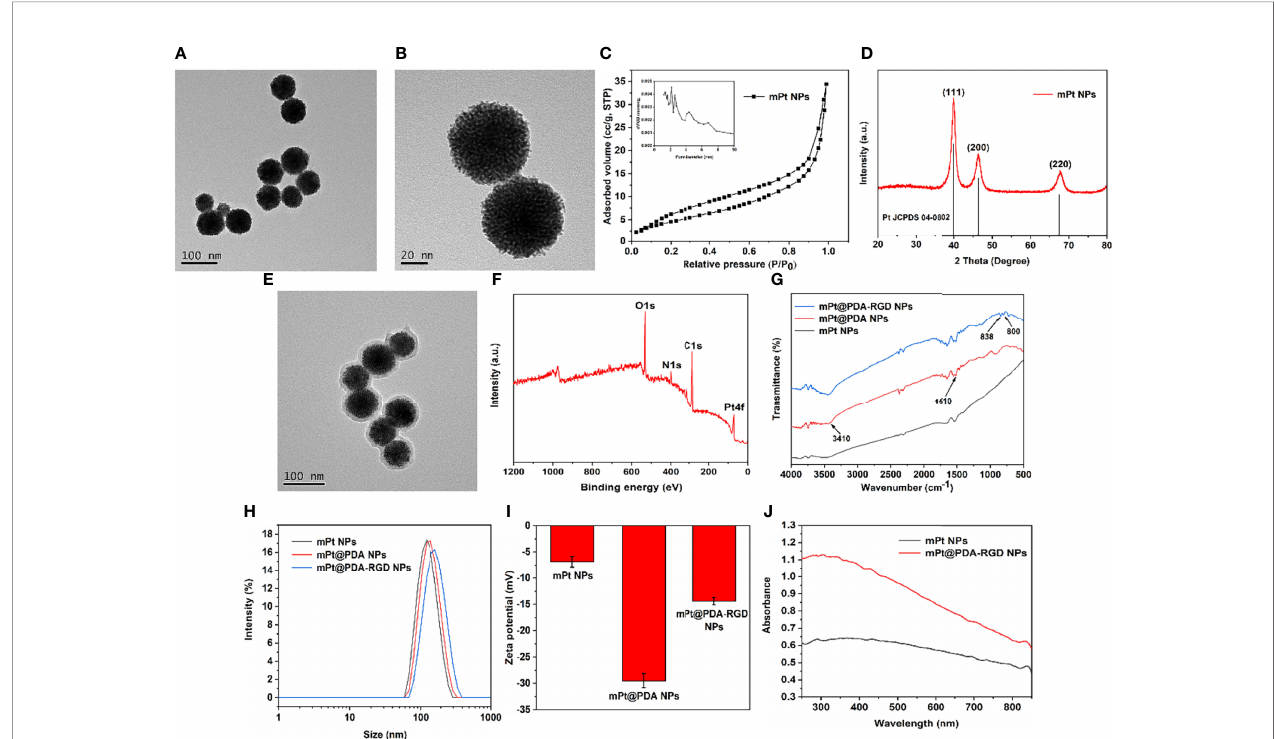
FIGURE 1 | Transmission Electron Microscope (TEM) images of mPt NPs (A, B) . Pore size distribution (C) and X-ray diffraction (XRD) patterns (D) of mPt NPs. (E) TEM image of mPt@PDA NPs. X-ray photoelectron spectroscopy (XPS) spectra (F) of mPt@PDA NPs. (G) Fourier transform infrared spectroscopy (FTIR)